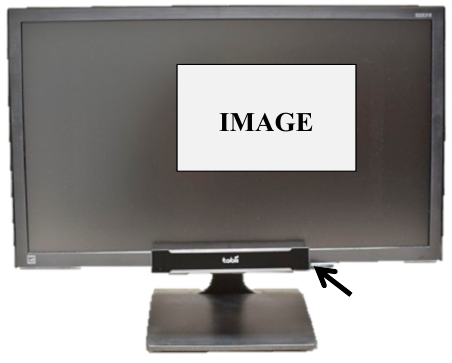
Figure 2. The experimental set-up showing the computer monitor and Eye Tracking camera.